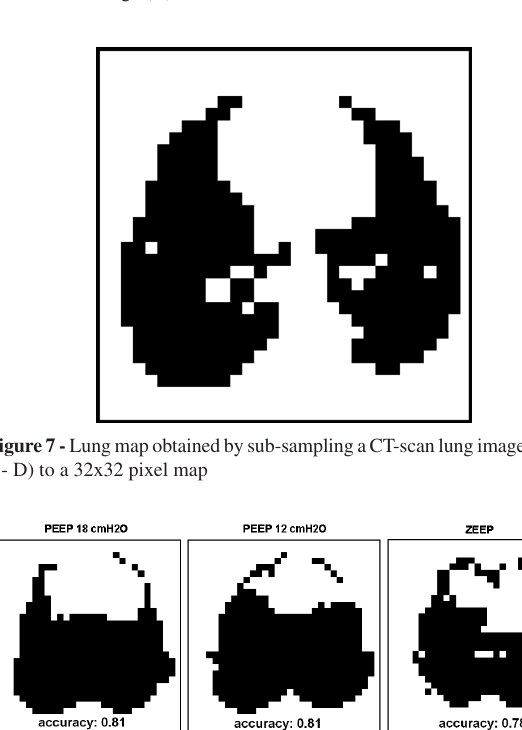
O, 12 cm H O and 2 2